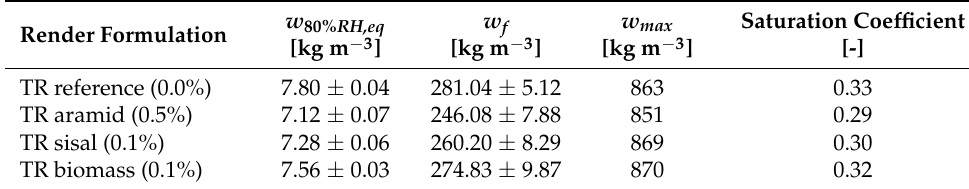
Table 4. Moisture storage properties and porosity results in synthesis.